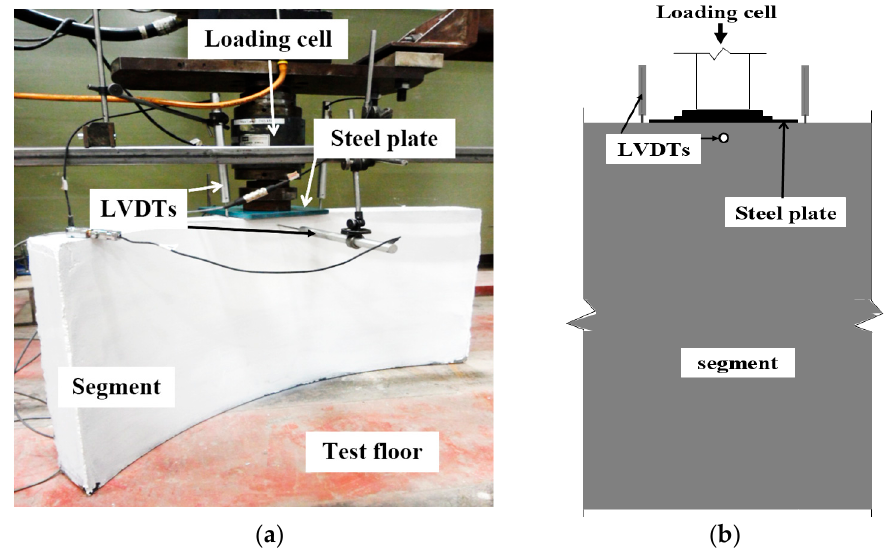
Figure 5. Thrust load test setup of lining segment: ( a ) Experimental test setup; ( b ) Schematic test setup (front view).